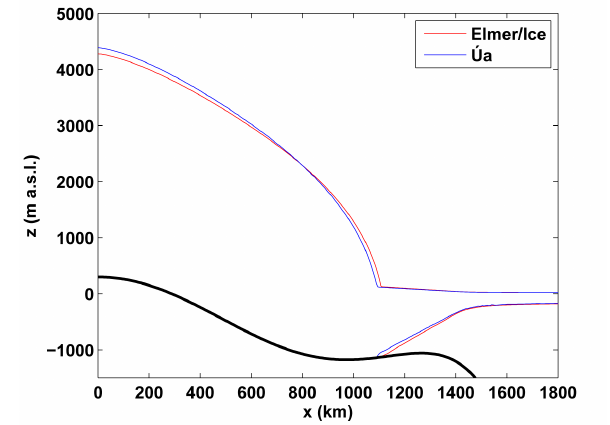
Fig. 5. Longitudinal surface profiles along the medial line ( y = 0) obtained with both the full Stokes solver Elmer/Ice (red lines) and the vertically-integrated solver ´ Ua (blue lines). The calculations were done for a channel half-width of w c = 50km. The thick black line is the ocean floor.